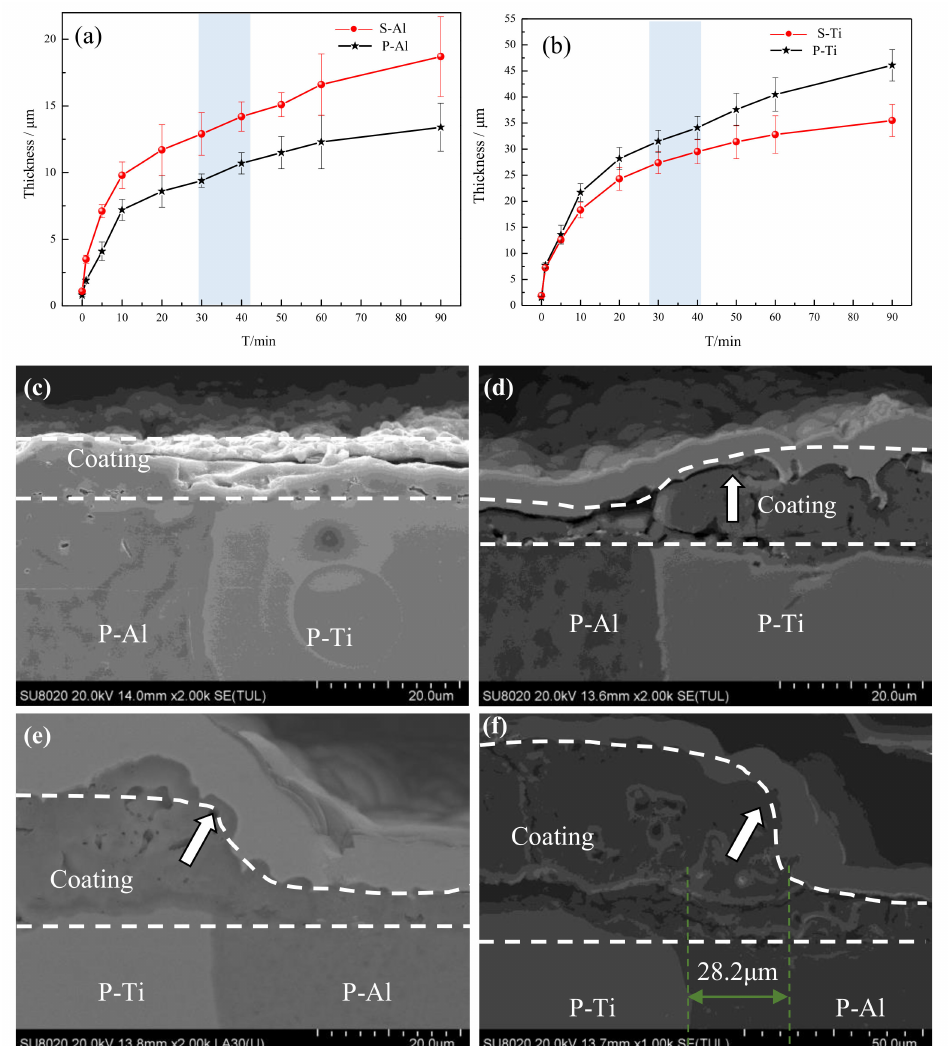
Figure 3. Dependence of thickness-time: ( a ) S-Al and P-Al coatings; ( b ) S-Ti and P-Ti coatings; growth process of coating on the welding joint: ( c ) 5 min; ( d ) 20 min; ( e ) 40 min; and ( f ) 90